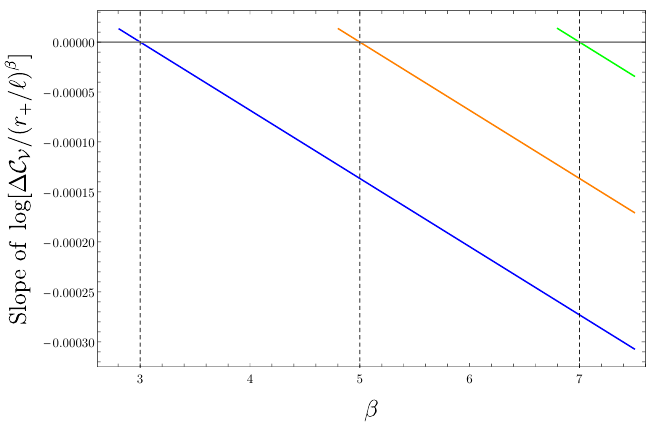
Figure 16. The slope of the logarithm of the ratio R ( β ) for several dimensions. The curves correspond to 5 dimensions (blue, left), 7 dimensions (orange, center), and 9 dimensions (green, right). For each value of β the integrals have been evaluated for 500 points laying between r + /‘ = 10 , 000 and r + /‘ = 20 , 000 . The slope is extracted by performing a linear fit to this